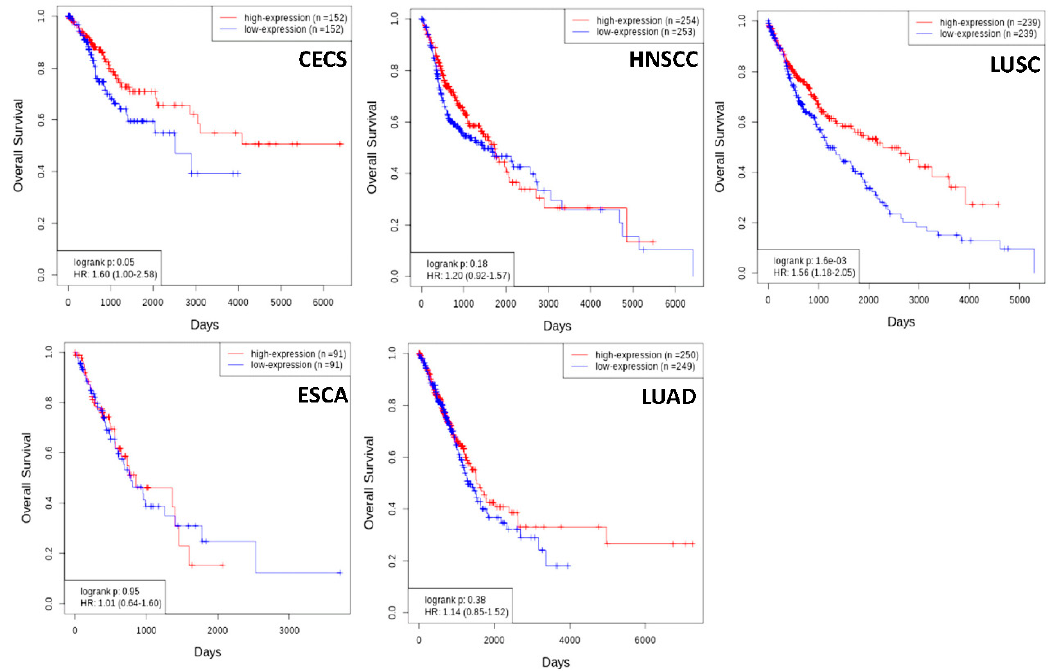
Figure 4. High expression of PAX9 mRNA is associated with a favorable prognosis in cervical